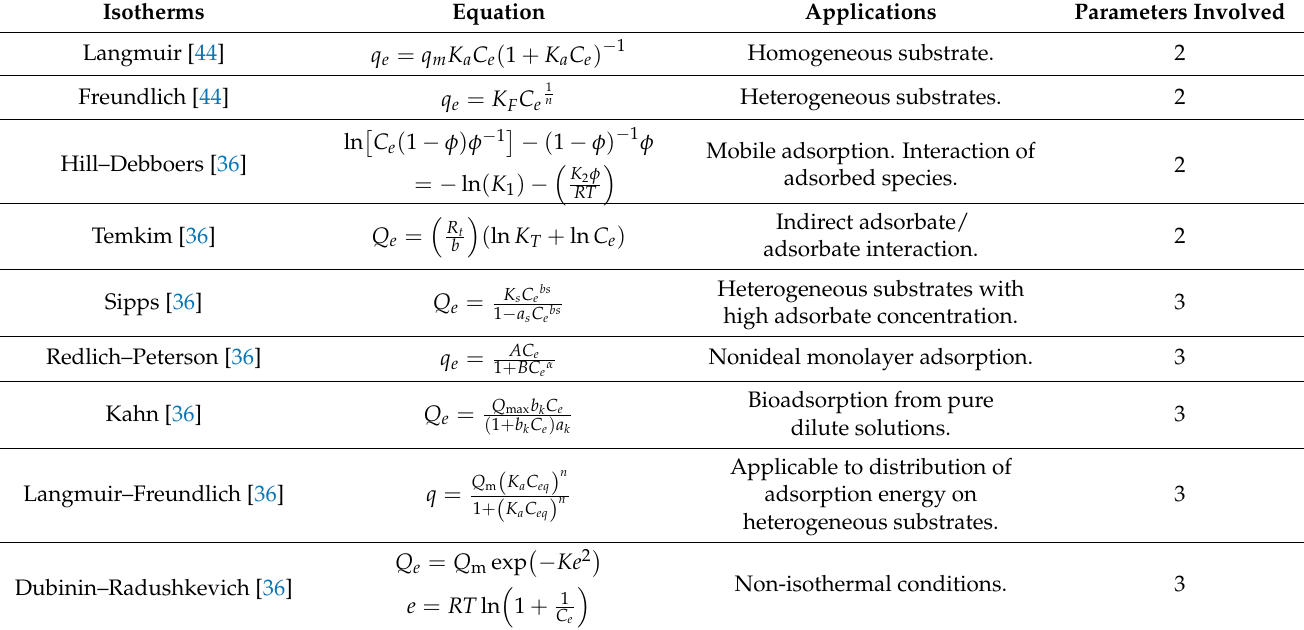
Table 1. A brief summary of the various isotherms applicable to modeling batch biosorption data.